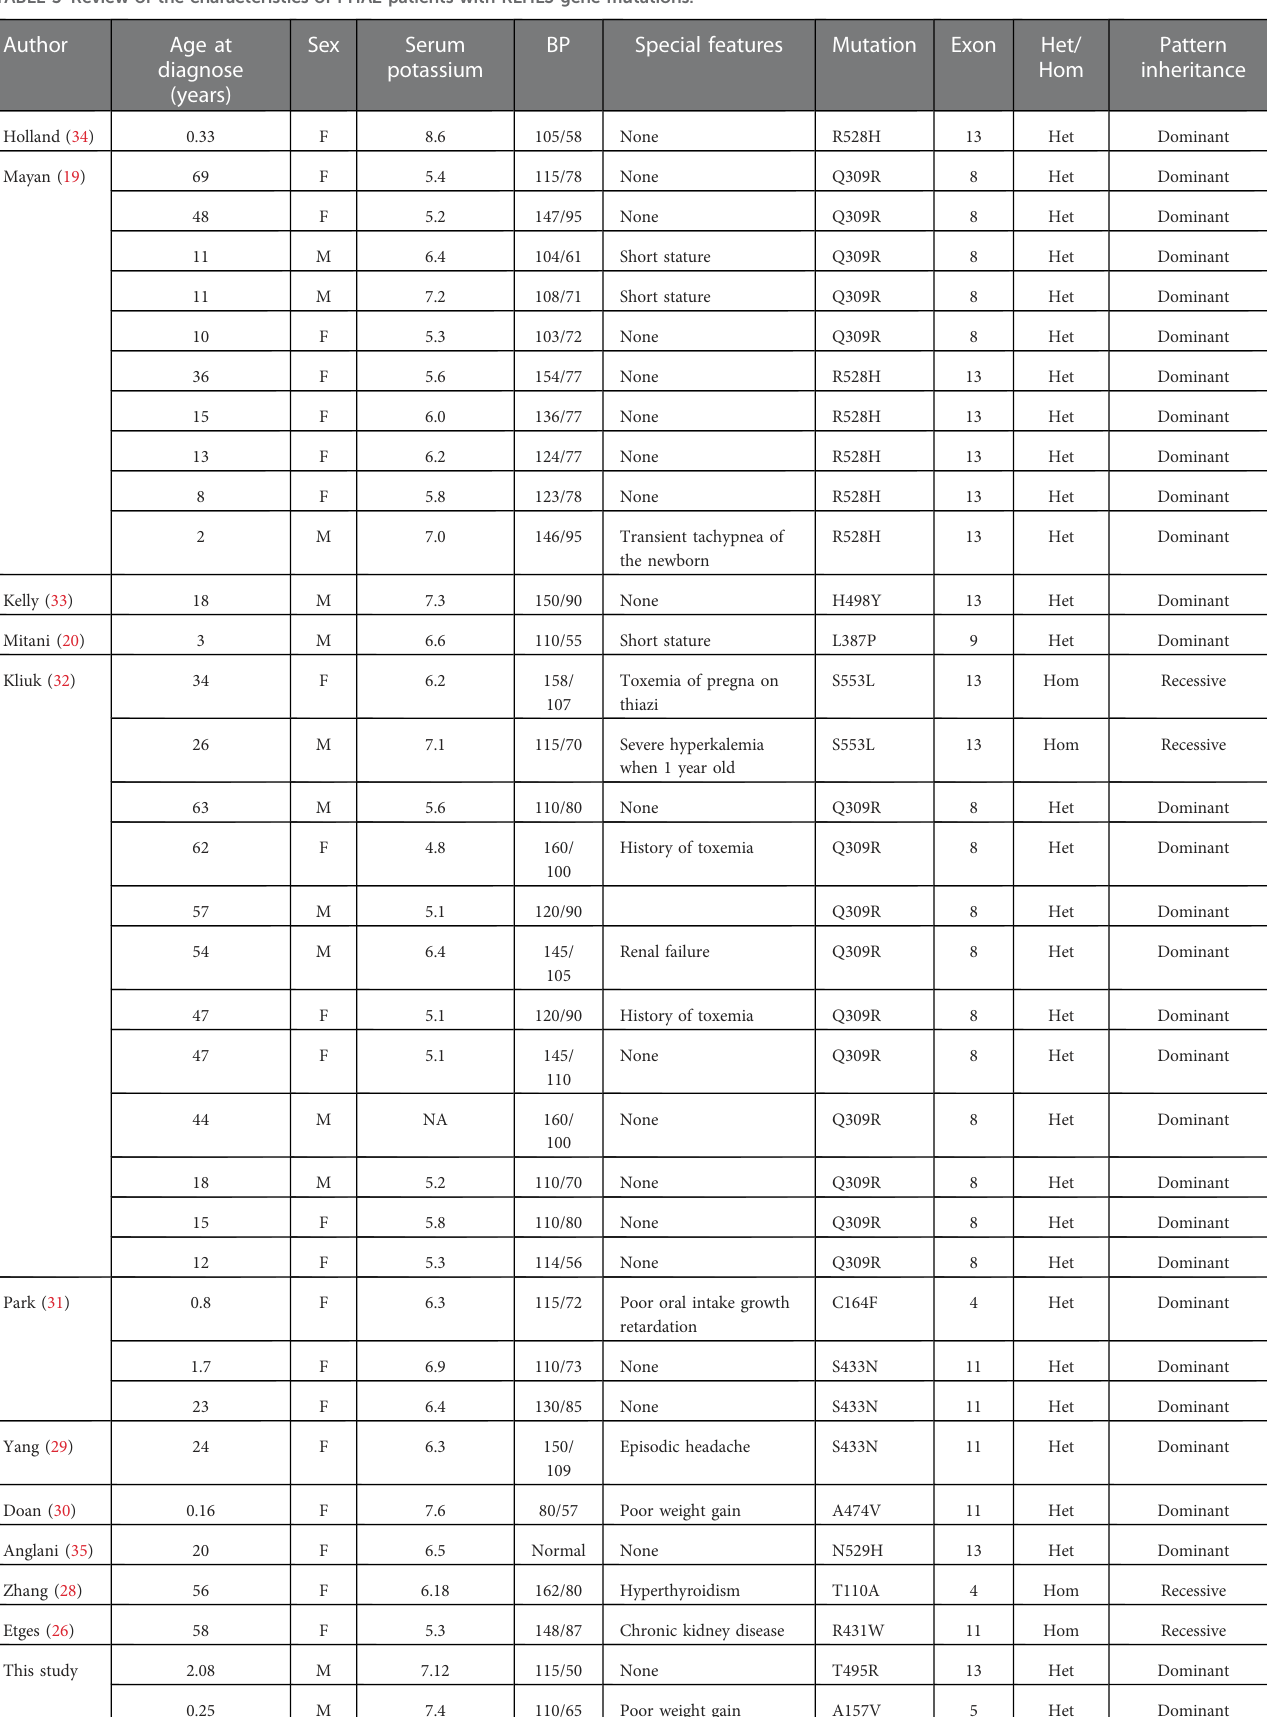
TABLE 3 Review of the characteristics of PHA2 patients with KLHL3 gene mutations. Author Age at diagnose